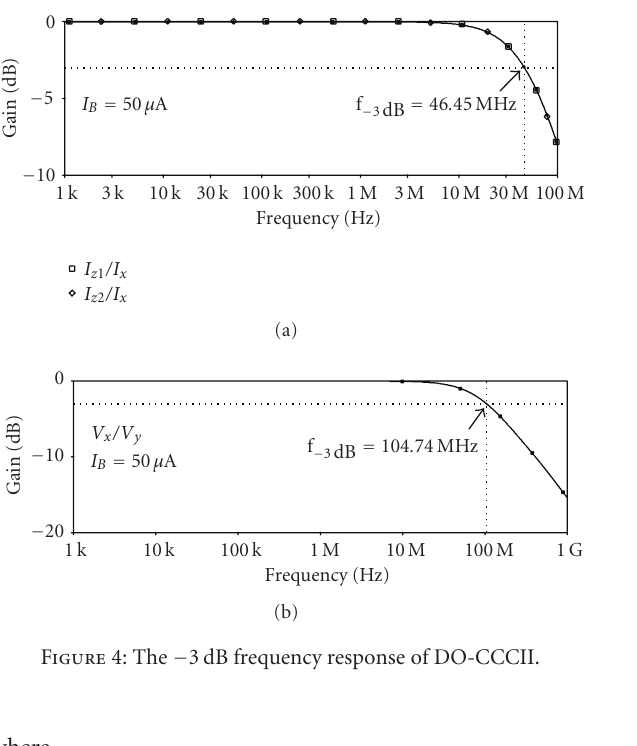
Figure 4: The − 3dB frequency response of DO-CCCII.